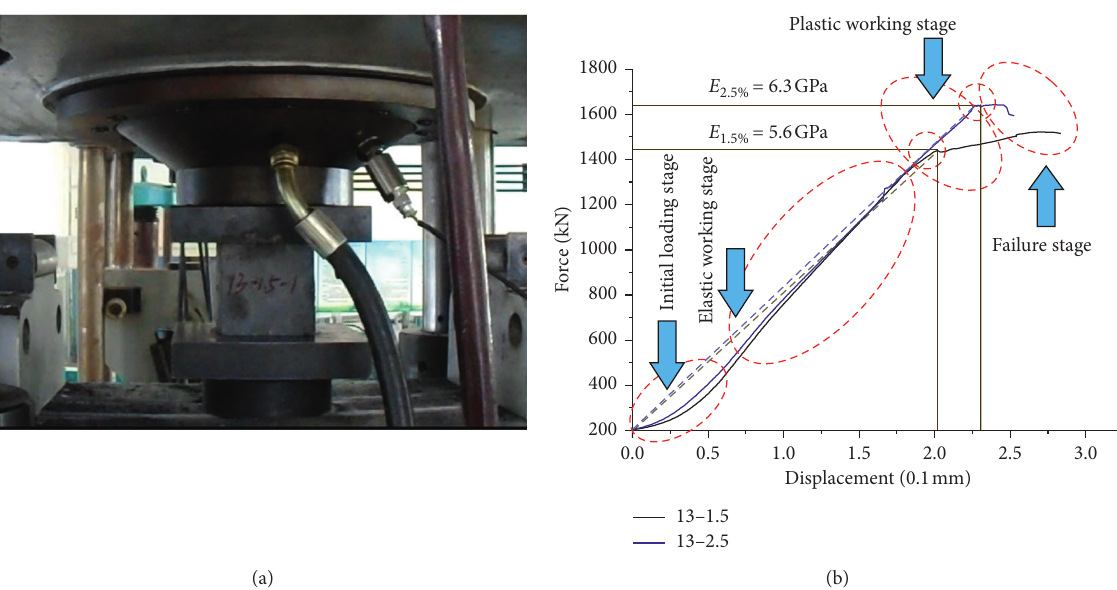
Figure 9: (a) Loading process of cube specimen; (b) load-displacement curve of specimens with 1.5% and 2.5% steel